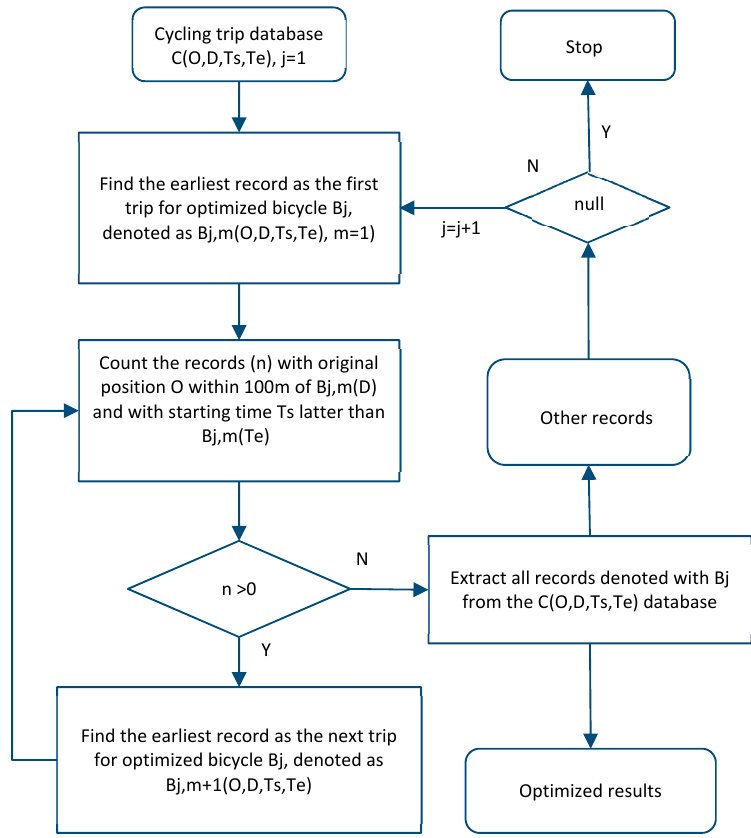
Figure 2. The calculation process of the